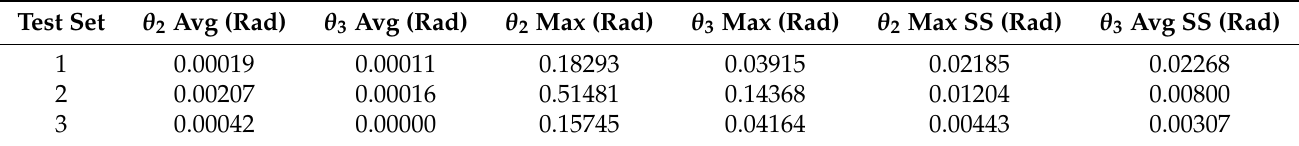
Table 6. Errors in θ 2 , θ 3